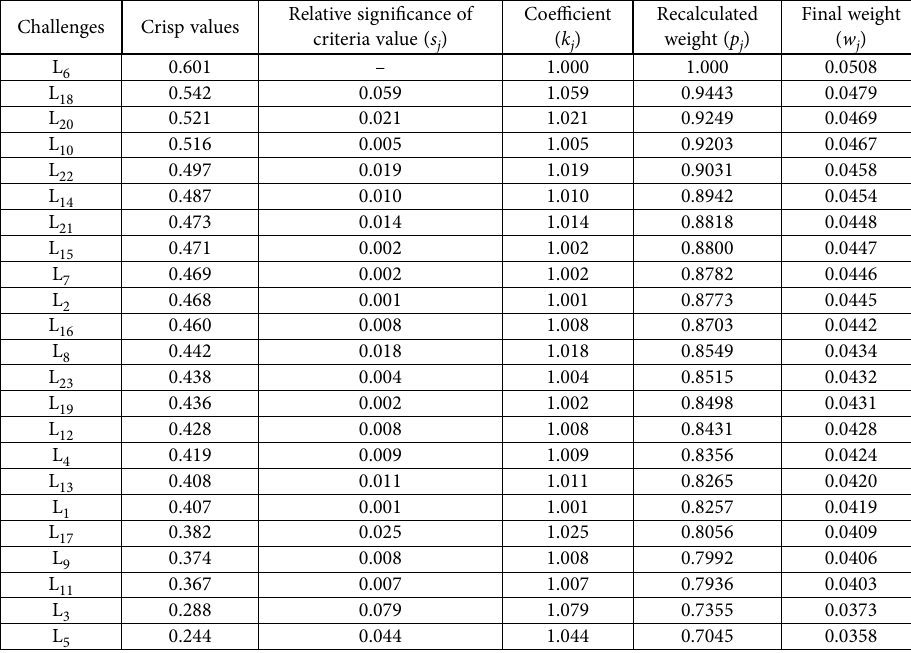
Table 8. Significance degree of challenges to implementing of G-IoT technologies using SWARA method Challenges